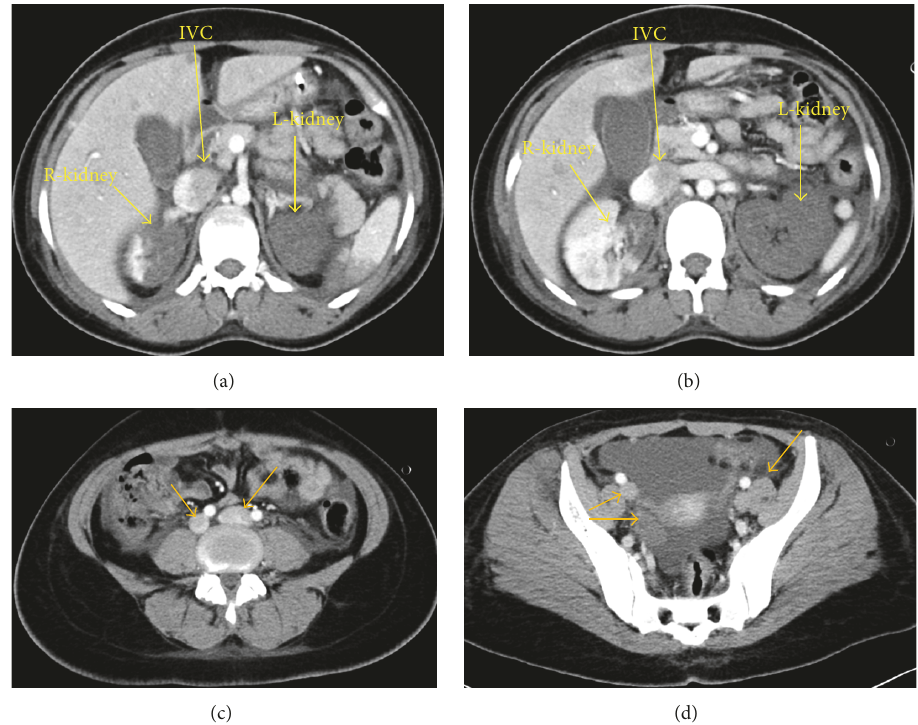
Figure 2: CECT abdomen showing partial infarction of the right kidney, totally nonperfused hypodense (completely infarcted) left kidney with thrombosis of distal left renal artery and proximal left renal vein. Inferior vena cava is seen partially filled with contrast (a, b) while nonenhancement is evident in distal to left renal vein. Thrombosis of inferior vena cava is seen extending into bilateral internal and external iliac veins and then into bilateral femoral veins (yellow arrows) (c,